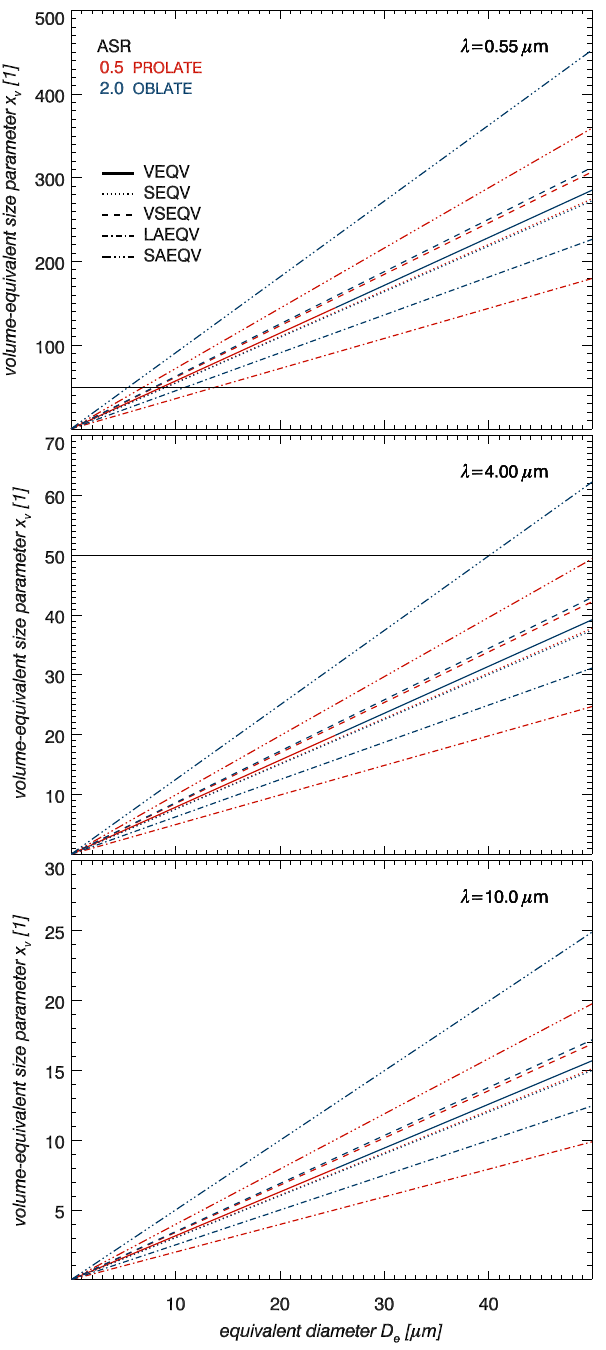
Fig. 2. Volume-equivalent size parameter x v as a function of the equivalent diameter D e of a measured particle, which is represented by a prolate and an oblate model spheroid with an AR of 2 : 1 in cases of five types of size equivalence. (top) At 550nm, (centre) at 4µm and (bottom) at 10µm wavelength. The horizontal black lines in the top and centre figures correspond to a size parameter of 50, an approximate value above which current exact scattering codes do not